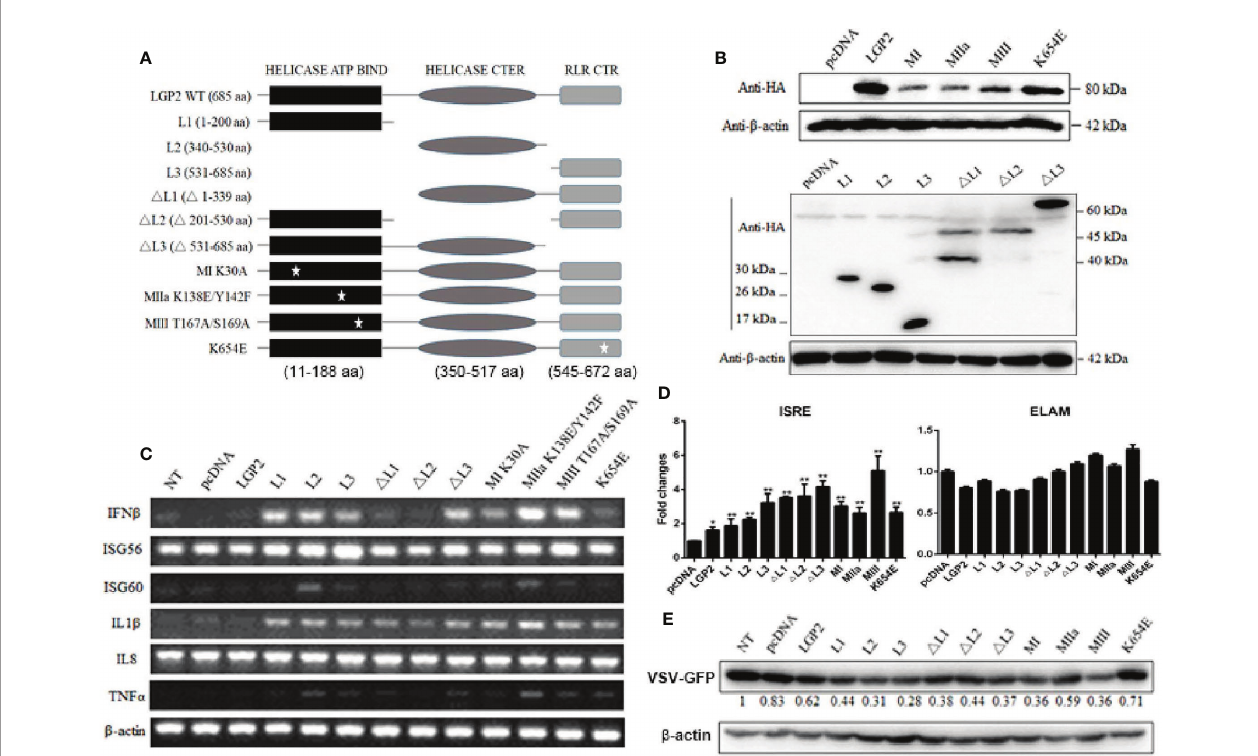
FIGURE 8 | Expression of pLGP2 mutants and their positive regulation on pRIG-I and pMDA5. (A) The pLGP2 protein structure and domains predicted by UniProt (https://www.uniprot.org). (B) The protein expressions of pLGP2 domains, deletion mutants and point mutants in transfected 293T cells. (C) PAMs grown in 12-well plates (5×10 5 cells) were transfected with pLGP2 mutants (1 m g each) using TransIT-LT1 Transfection Reagent for 24 h. The cells were analyzed by RT-PCR for the expressions of downstream genes. (D) PAMs grown in 96-well plates (1×10 4 cells/well) were transfected with pLGP2 and its mutants (20 ng each) plus ISRE- Fluc/ELAM-Fluc (10 ng) and Rluc (0.2 ng), using the TransIT-LT1 Transfection Reagent. Twenty-four hours post transfection, the luciferase activities were measured. (E) PAMs grown in 12-well plates (5×10 5 cells) were transfected as in (C) , then infected with 0.01 MOI VSV-GFP for 12 h. The cells were analyzed by Western- blotting with anti-GFP mAb, and the GFP densitometric values after normalization by actin were shown below. * p < 0.05, ** p < 0.01 vs pcDNA